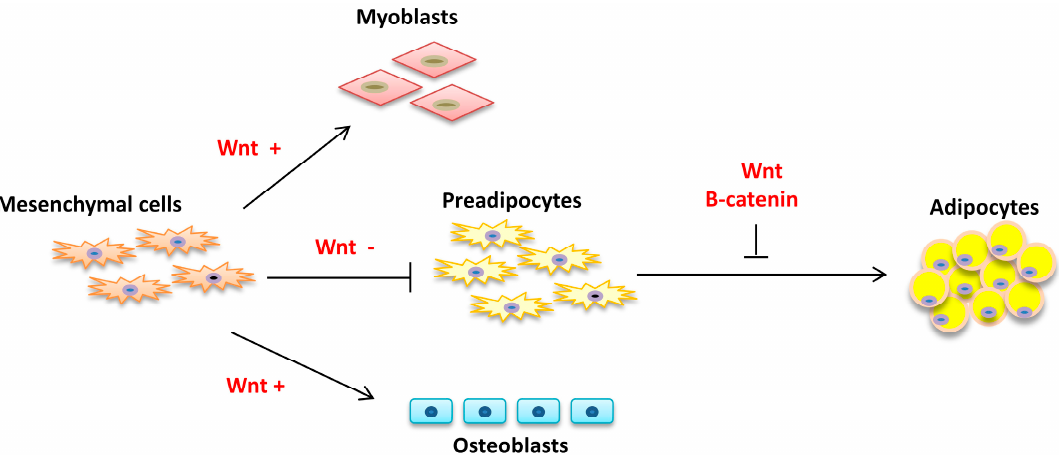
Figure 1. Mesenchymal stem cell fate is regulated by WNT signaling. The activation of WNT/ β -catenin signaling order the differentiation of mesenchymal cells into myoblasts and osteoblasts while the commitment of mesenchymal cells to the adopocytic lineage is suppressed.